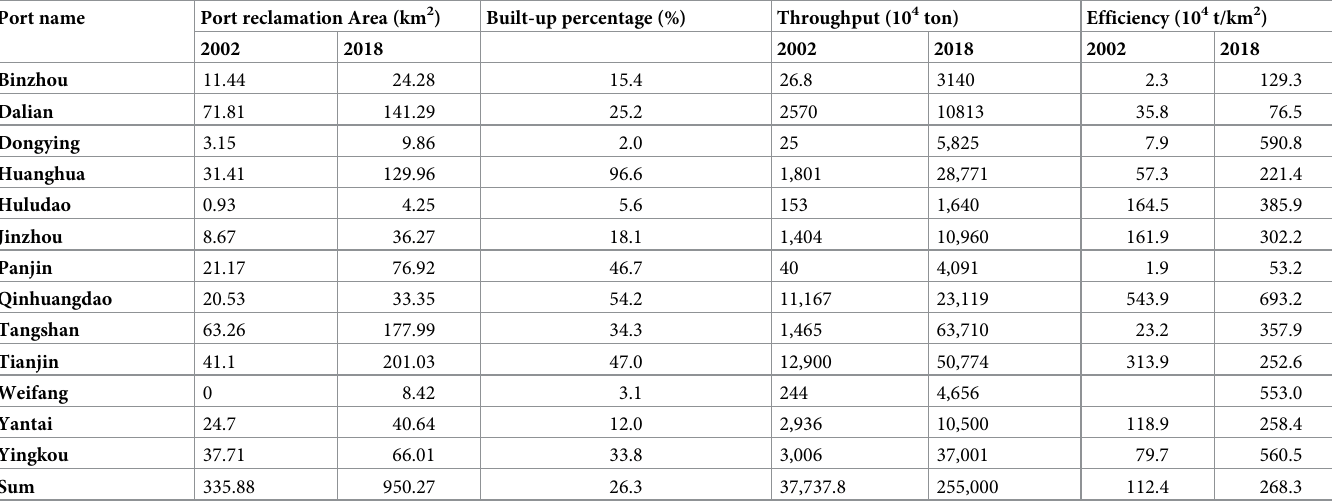
Table 3. Changes of port reclamation area, port built-up percentage, throughput, and land use efficiency during 2002–2018 in the Bohai Sea. Port name Port reclamation Area (km 2 )